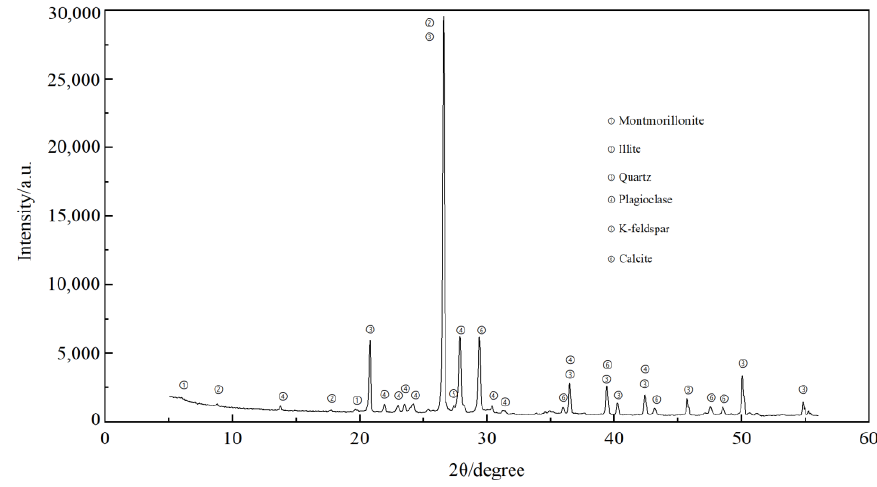
Figure 3. The mineral X-ray diffraction pattern of the core sample. Table 2. The result of X-ray diffraction quantitative analysis of core sample.